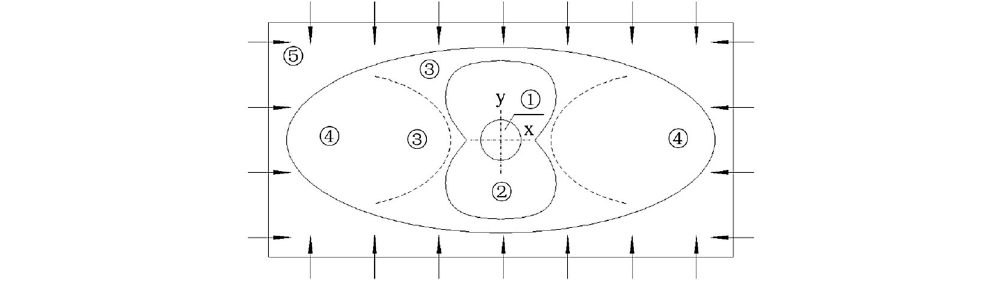
Fig. 2 Zoning model of cumulative blasting-induced coal fractures (Guo et al.